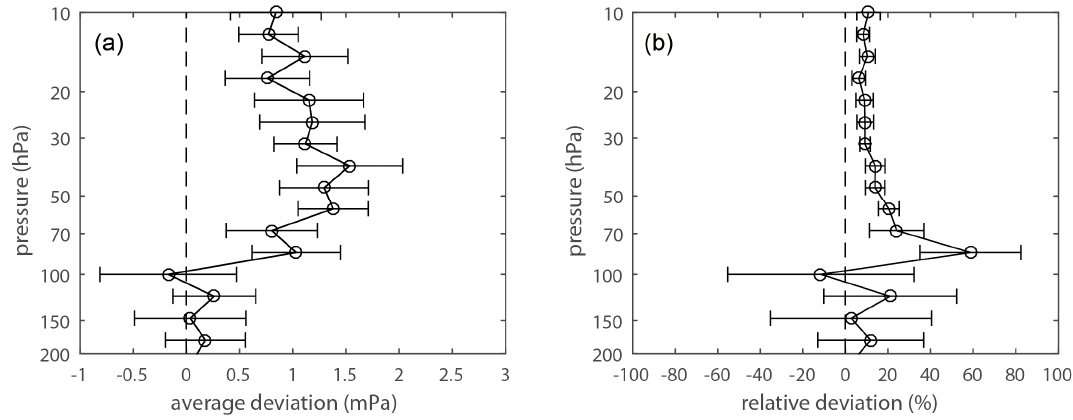
Figure 3. ( a ) Average deviation of MLS ozone profile relative to the ozonesonde profile with ±2 standard error. ( b ) As in (a), but for relative deviation.